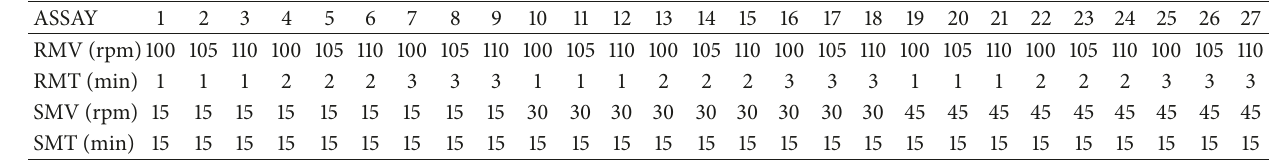
Table 1: Operational conditions of coagulation/flocculation and sedimentation process.